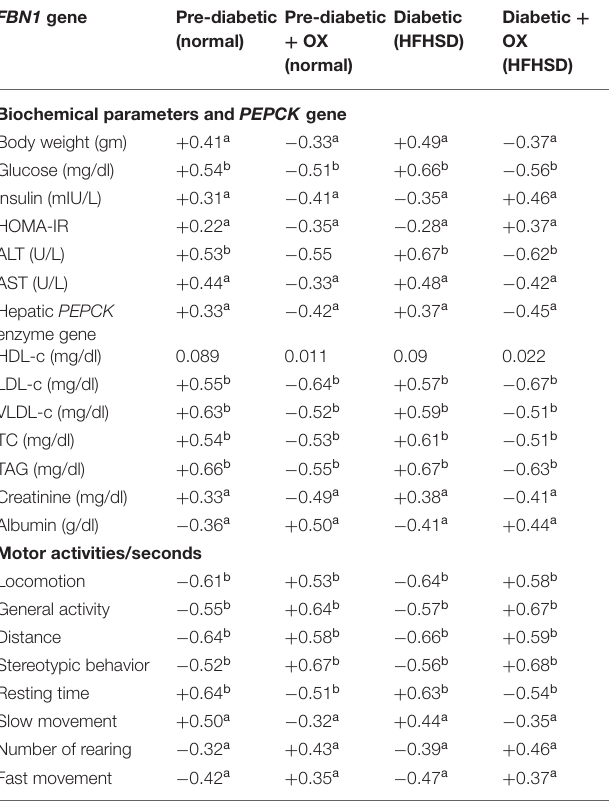
TABLE 5 | The correlation coefficients between biochemical parameters, PEPCK , and the behavioral activities with FBN1 gene expression in prediabetic and diabetic Wistar